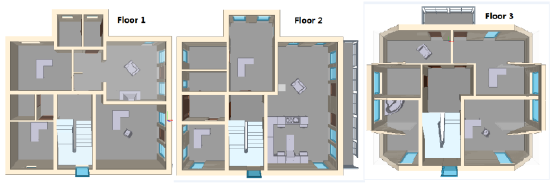
Figure 2. IFC model for Building 1 (left) and Building 2 (right)